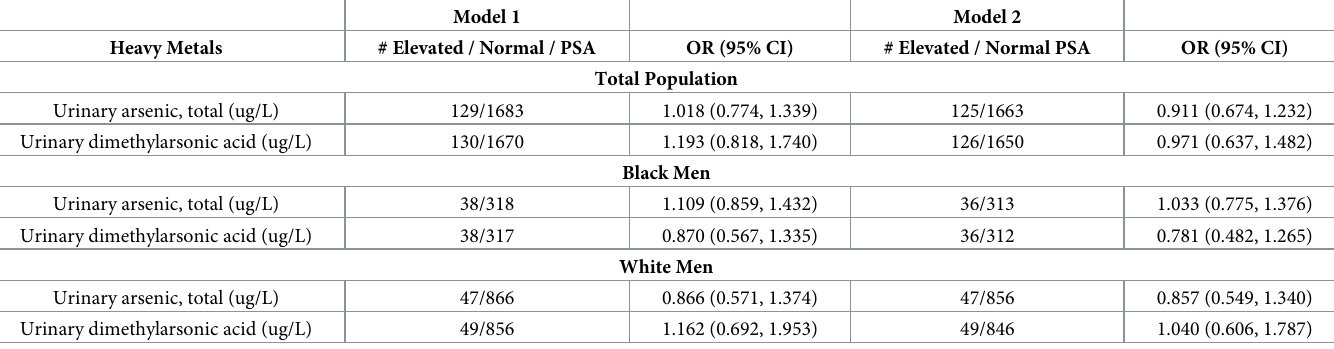
Table 3. Associations between urinary levels of total arsenic and dimethylarsonic acid and elevated serum PSA among 2003–2010 NHANES Men.